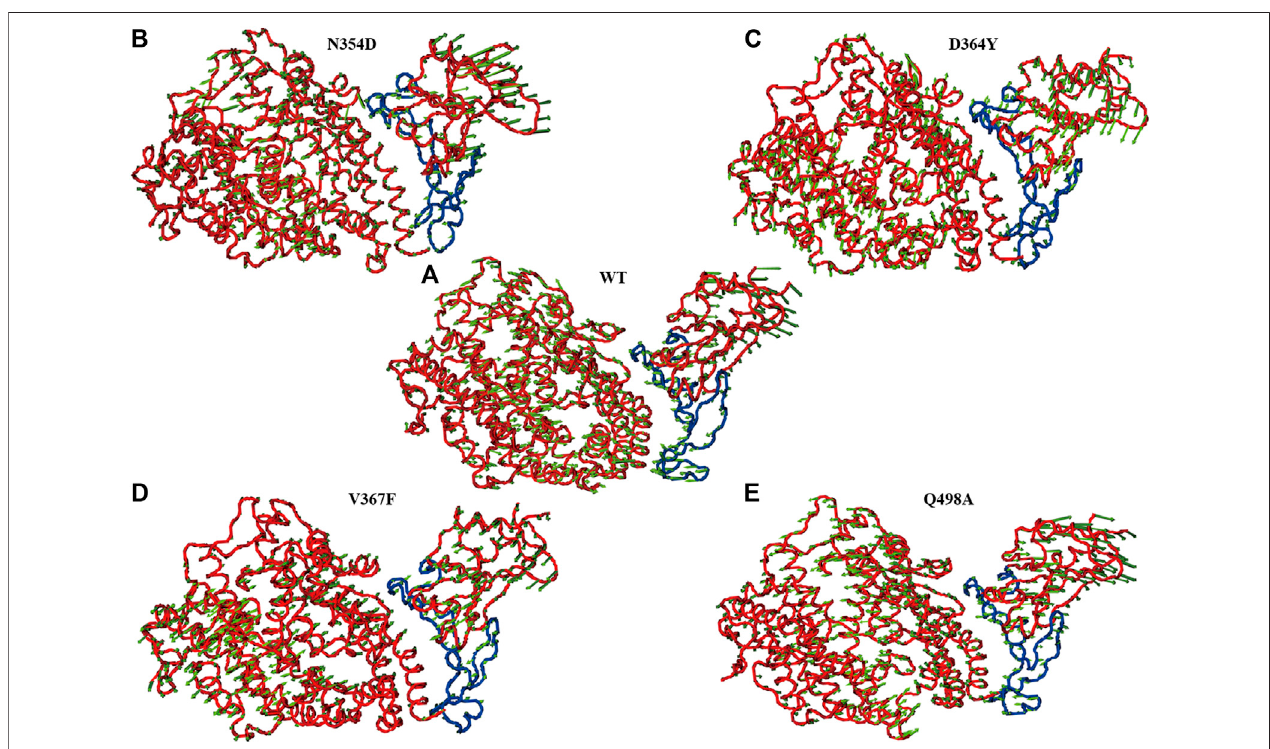
FIGURE 7 | Principal component analysis of each system. The arrow (green) plot of the fi rst (PC1) motion modes for the RBM (blue) region in the WT system (A) , N354D system (B) , D364Y system (C) , V367F system (D) , and Q498A system (E) .